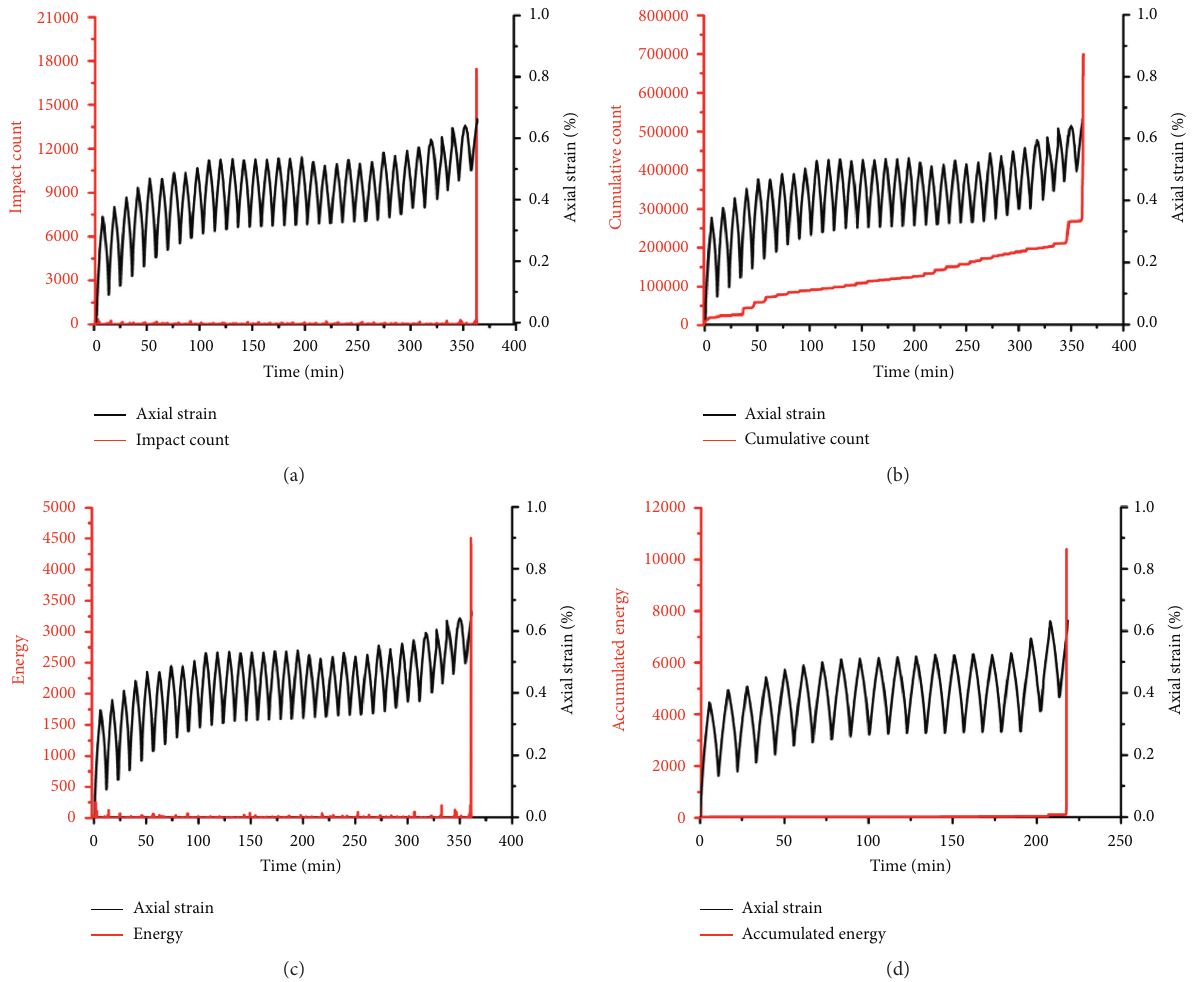
Figure 17: Deformation and acoustic emission characteristics of S-3-2 sample. (a) The curves of ringing count and axial strain of S-3-2 sample with time. (b) The curves of cumulative ringing count and axial strain of S-3-2 sample with time. (c) The curves of energy and axial strain of S-3-2 sample with time. (d) The curves of cumulative energy and axial strain of S-3-2 sample with